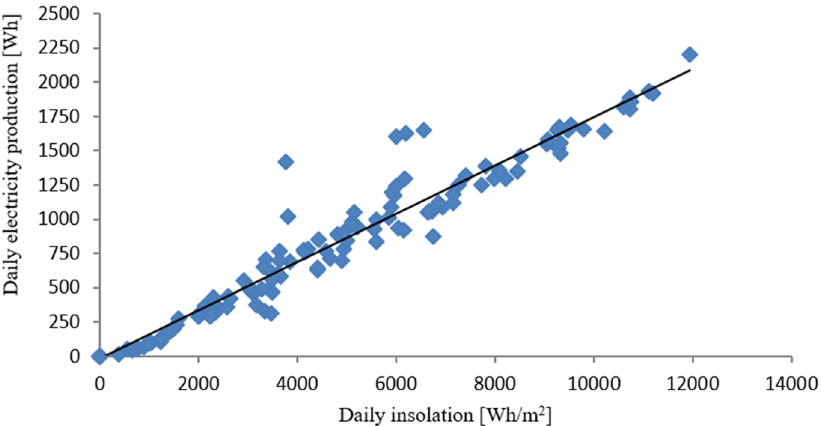
Figure 4. Impact of insolation on the value of electricity produced by the photovoltaic module in the fixed configuration.